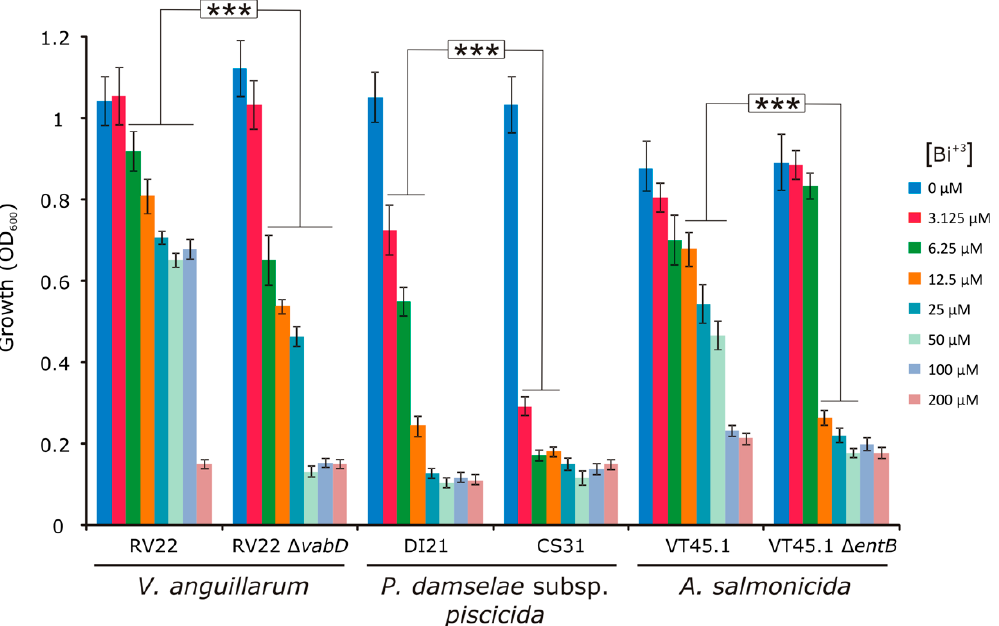
Figure 2 . Maximum growth achieved by V. anguillarum , P. damselae subsp. piscicida, and A. salmonicida subsp. salmonicida siderophore-producing strains compared to their derivative siderophore deficient strains. Bacteria were grown at 25 °C for 12 h in TSB-1 containing increasing concentrations (between 0 and 200 µM) of bismuth. Asterisks (***) denote statistically significant differences ( P < 0.001). OD = optical density.